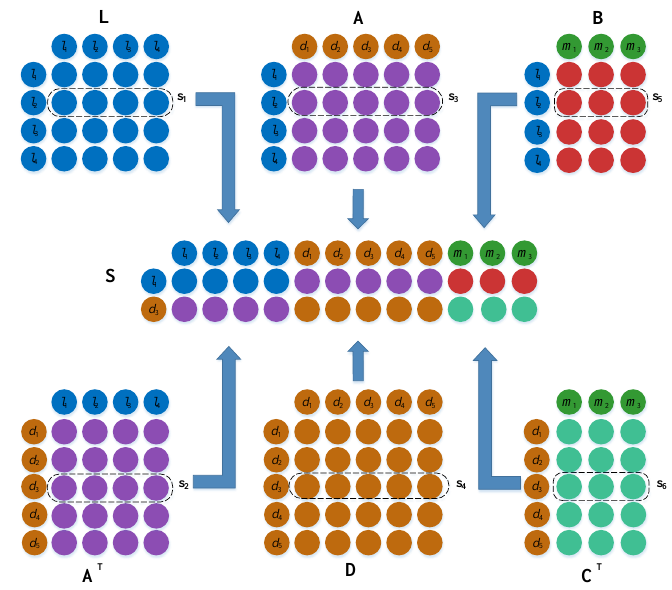
Figure 3. Construction of the original eigenmatrix of lncRNA l 2 and disease d 3 .